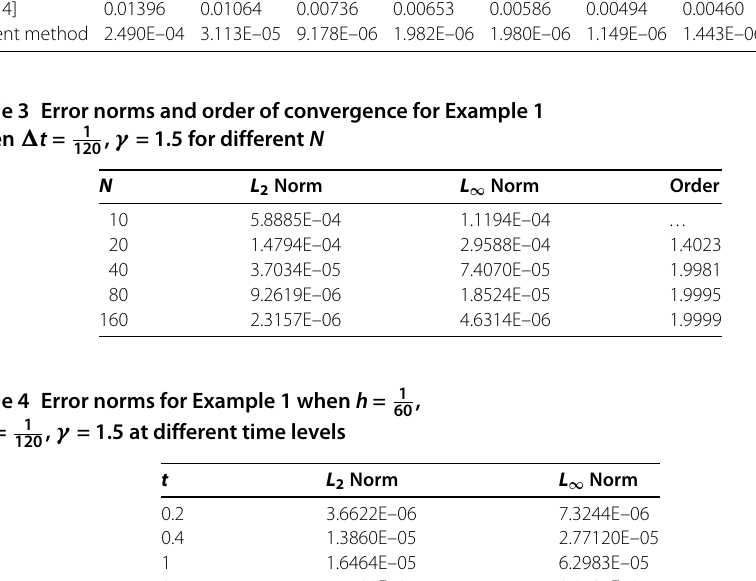
Table 2 The maximum error for Example 1 at different values of h , (cid:2) t for γ = 1.7 and t = 0.4 h 1 10